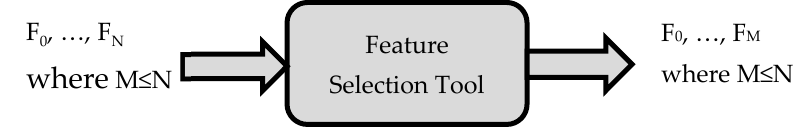
Figure 4. Feature selection using the FST tool.